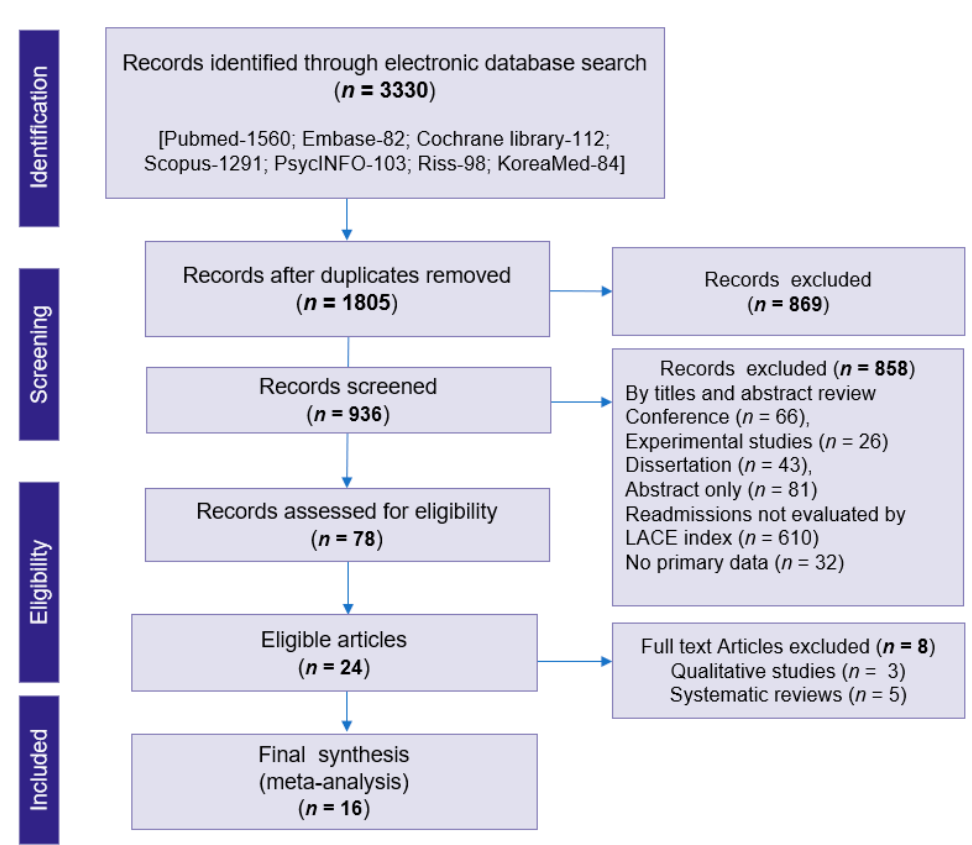
Figure 1. Flow diagram of studies included in the review based on the Preferred Reporting Items for Systematic Review and Meta-Analysis Guidelines.